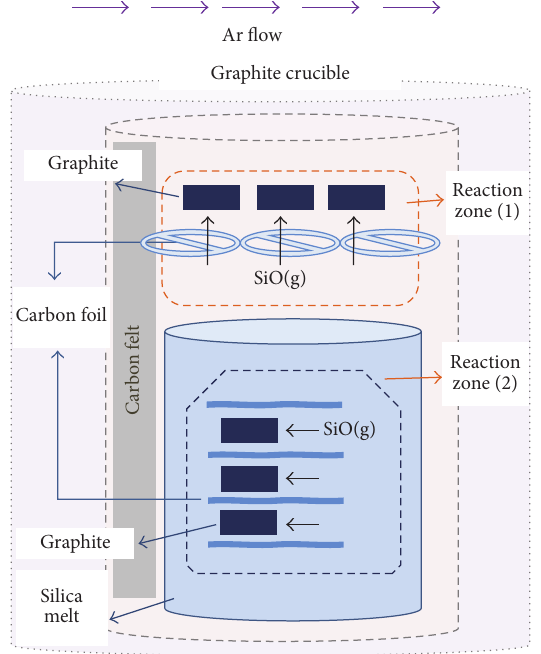
Figure 1: Schematic of chemical vapor reaction process for conver- sion